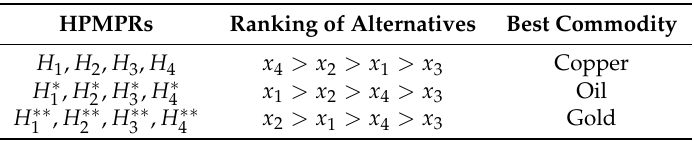
Table 4. Effects of probability on